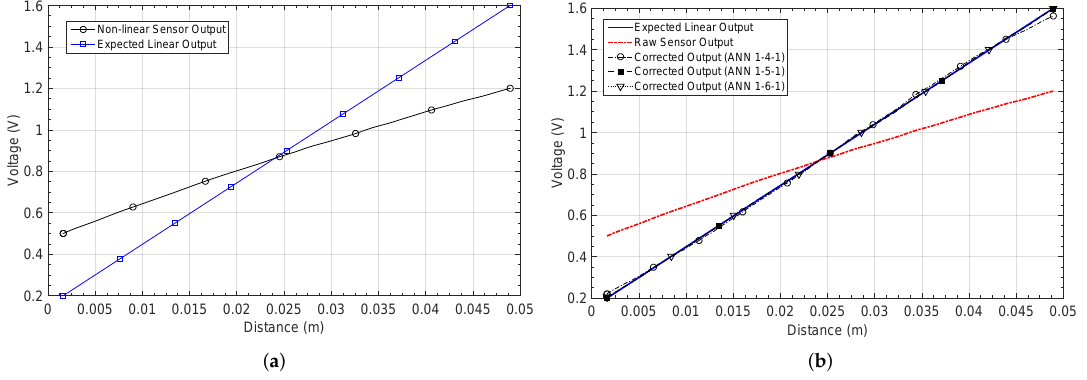
Figure 12. Hall-effect sensor response NL2 ( a ) before and ( b ) after correction.